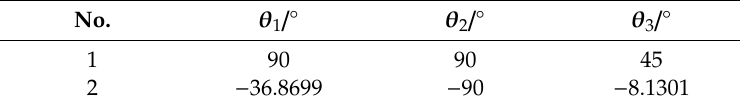
Table 8. Two inversely solved joint angle sets.